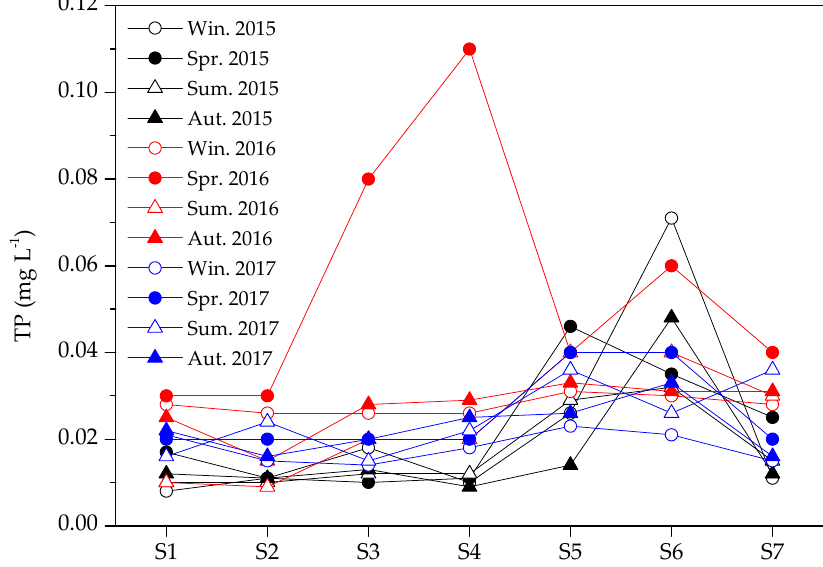
Figure 3. Seasonal changes in total phosphorus (TP) at different sampling sites in Gaozhou Reservoir from 2015 to 2017.